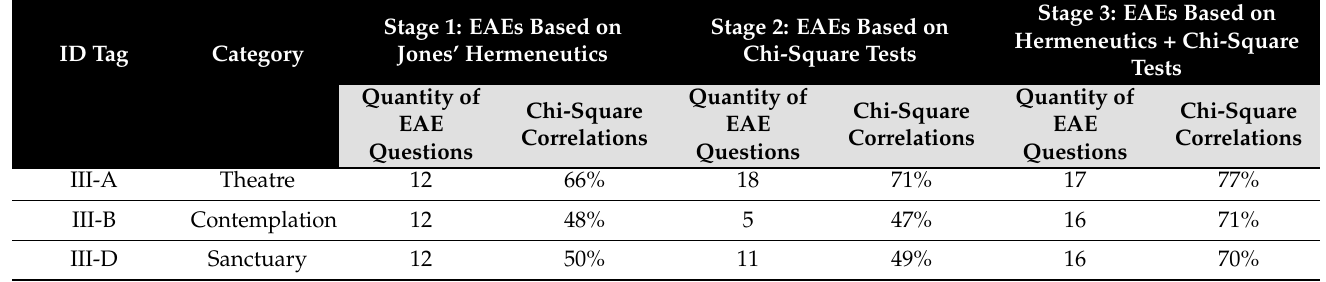
Table 2. Summary of the findings from the three stages of statistical testing that were used to link EAE survey questions to Jones’ morphological categories. The table outlines the quantity of EAE questions found in each ritual context during the testing period and the percentage of Chi-Square correlations for each